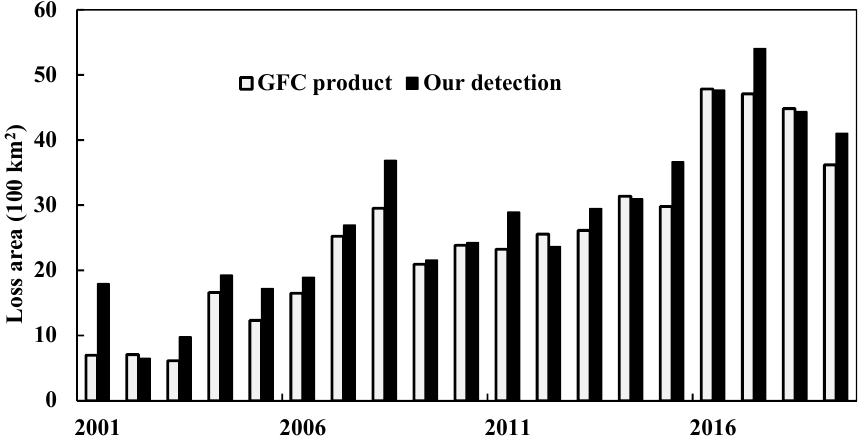
Figure 13. Comparison between our detected forest loss area and from NFI and Forestry Statistical Yearbook in each five year period during 1986–2018. Note: the loss area due to forest insect and disease is calculated by subtracting the prevention area from the total occurrence area.